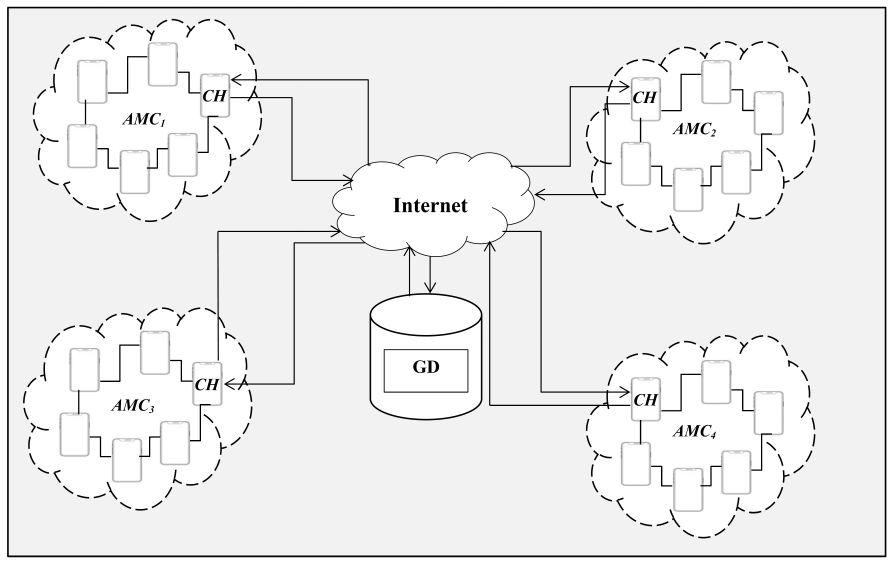
Figure 1. The proposed MACRS